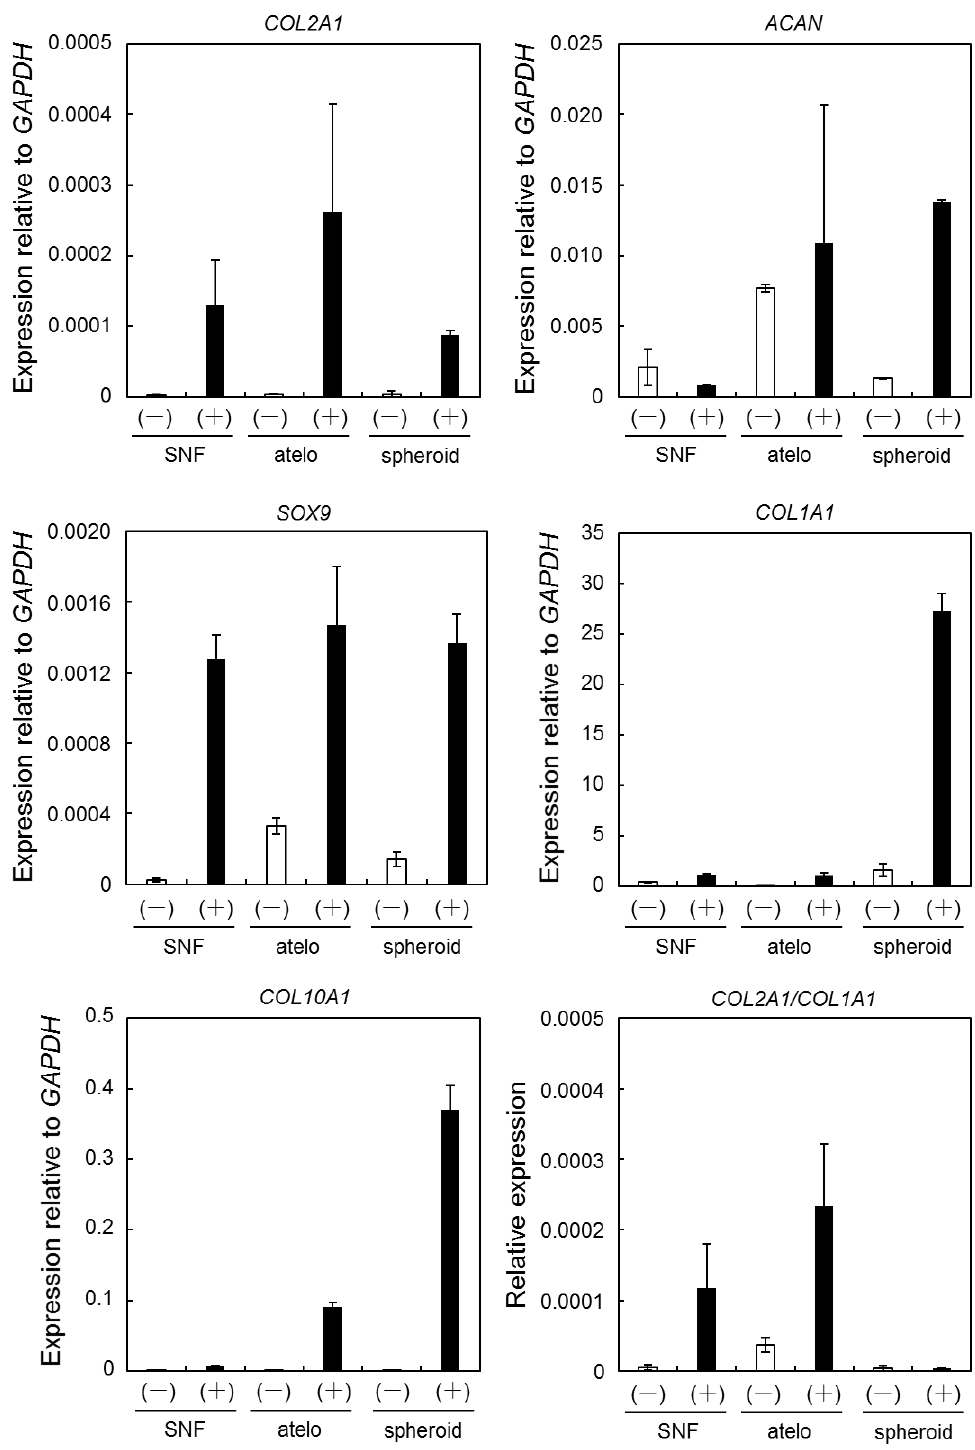
Figure 5. The expression of COL1A1, COL2A1 , COL10A1, ACAN, and SOX9 in mesenchymal stem cells (MSCs) cultured on 3D silica fibers in normal medium (Diff (−)) and chondrogenic differentiation medium (Diff (+)). Signal intensity was normalized using that of a control housekeeping gene (human GAPDH gene).